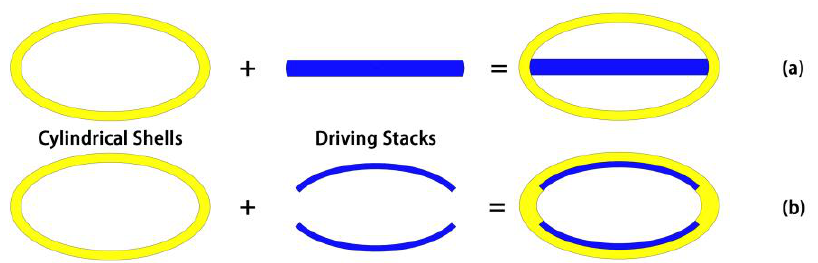
Figure 1. ( a ) The structure of conventional driving Class IV FTs; ( b ) The structure of conformal driving Class IV FTs.